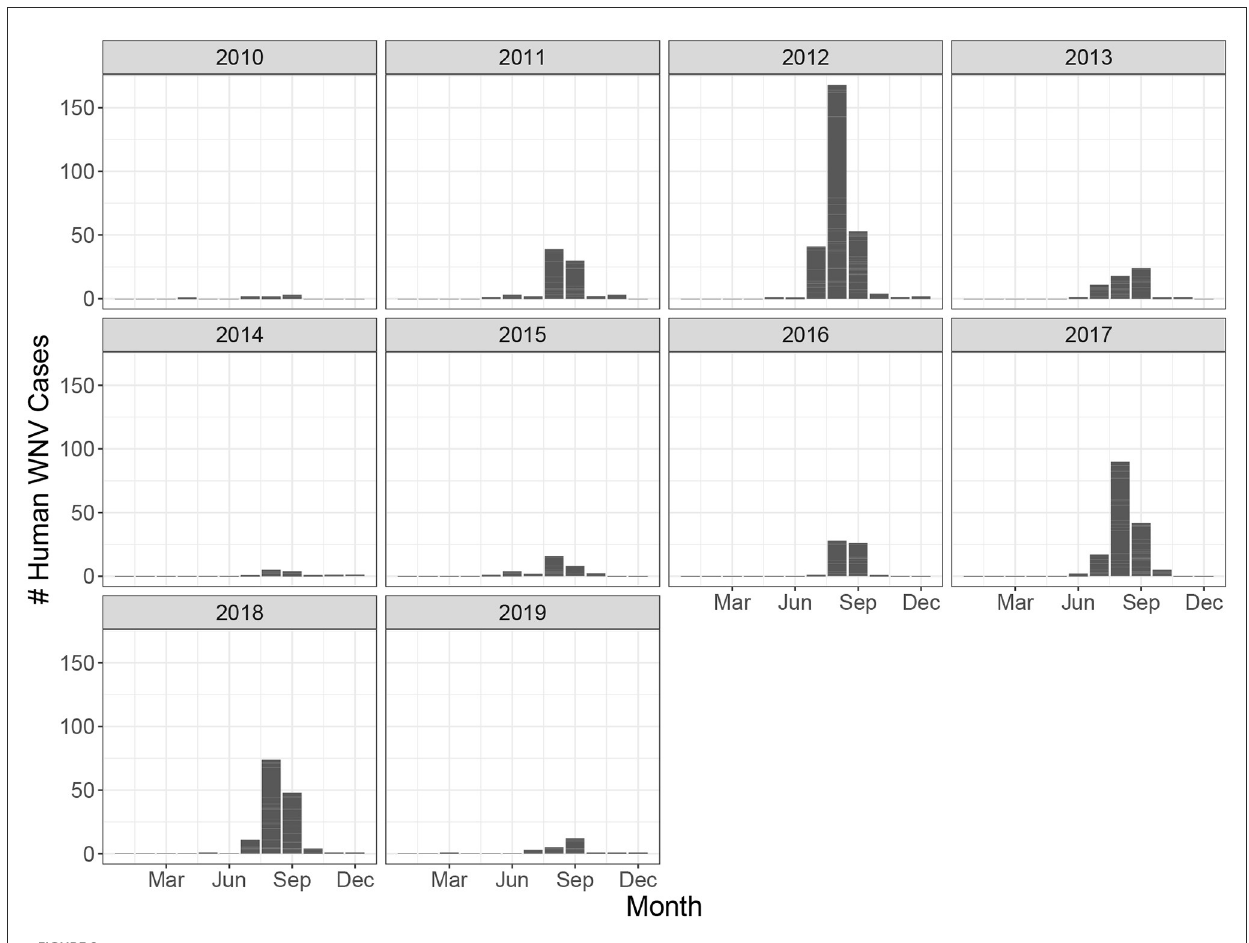
FIGURE2 Monthly human West Nile virus cases in all of Ontario from 2010 to